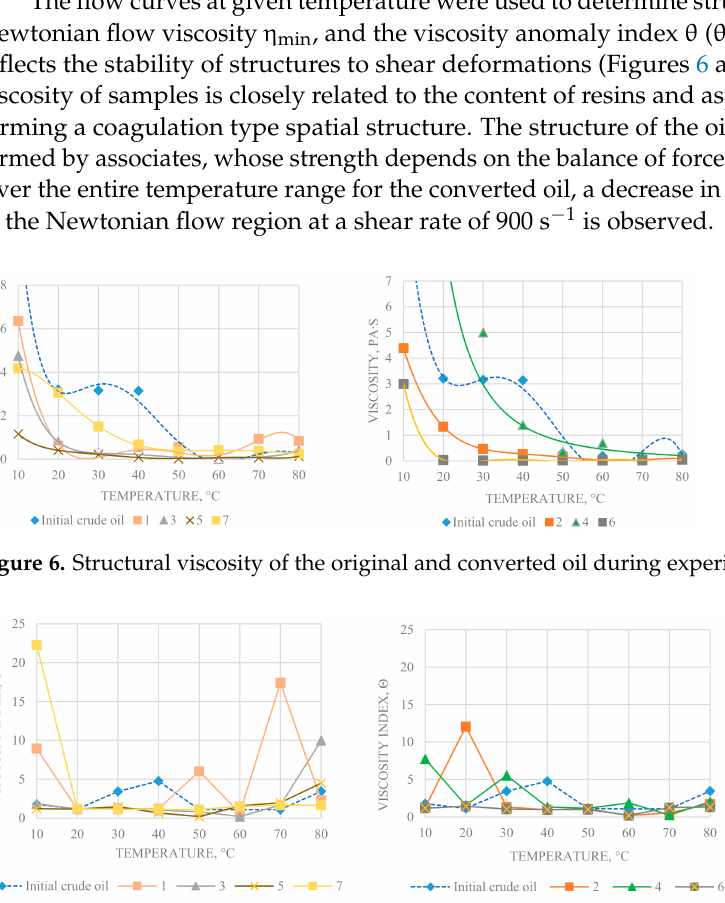
Figure 7. Viscosity anomaly index of initial and converted oil during experiments